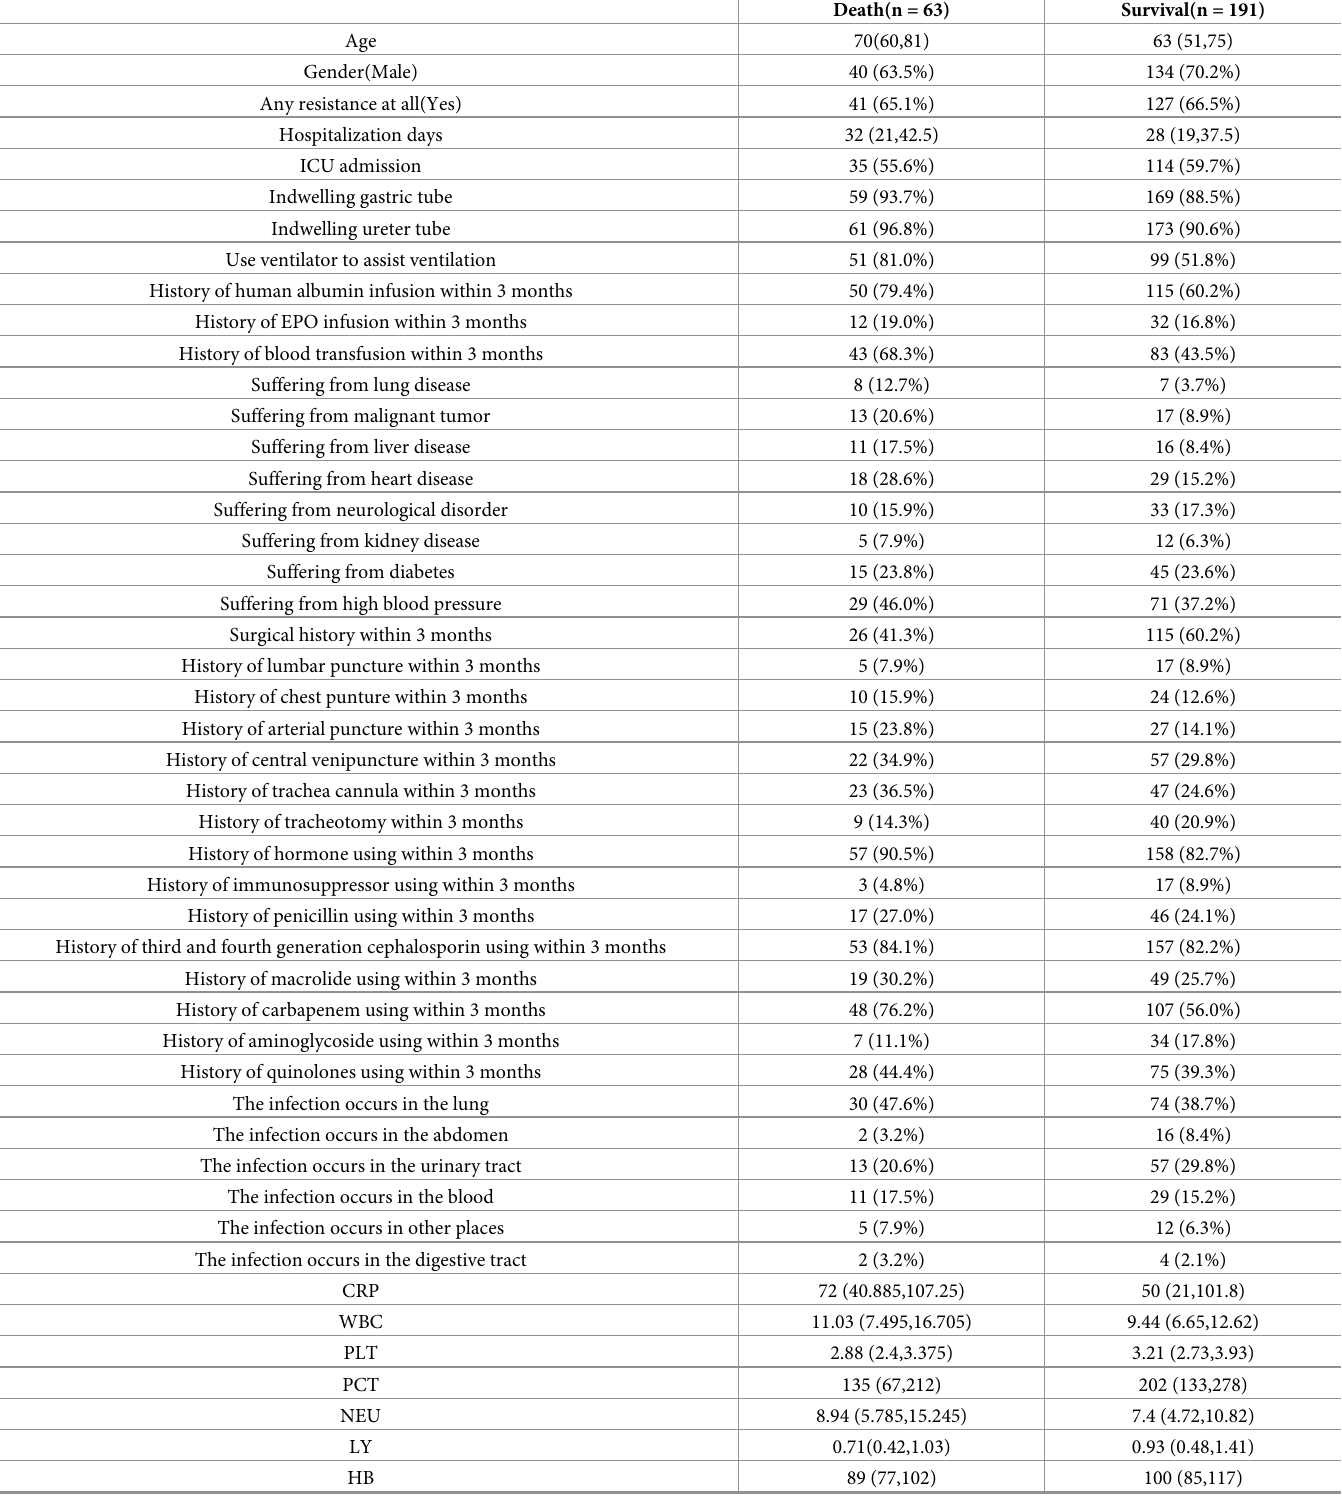
Table 1. Baseline